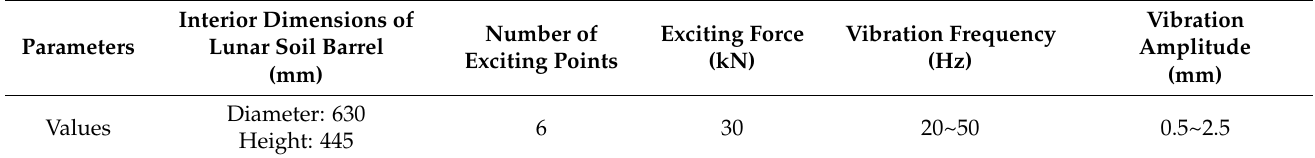
Table 5. The performance parameters of lunar soil simulant preparation device.